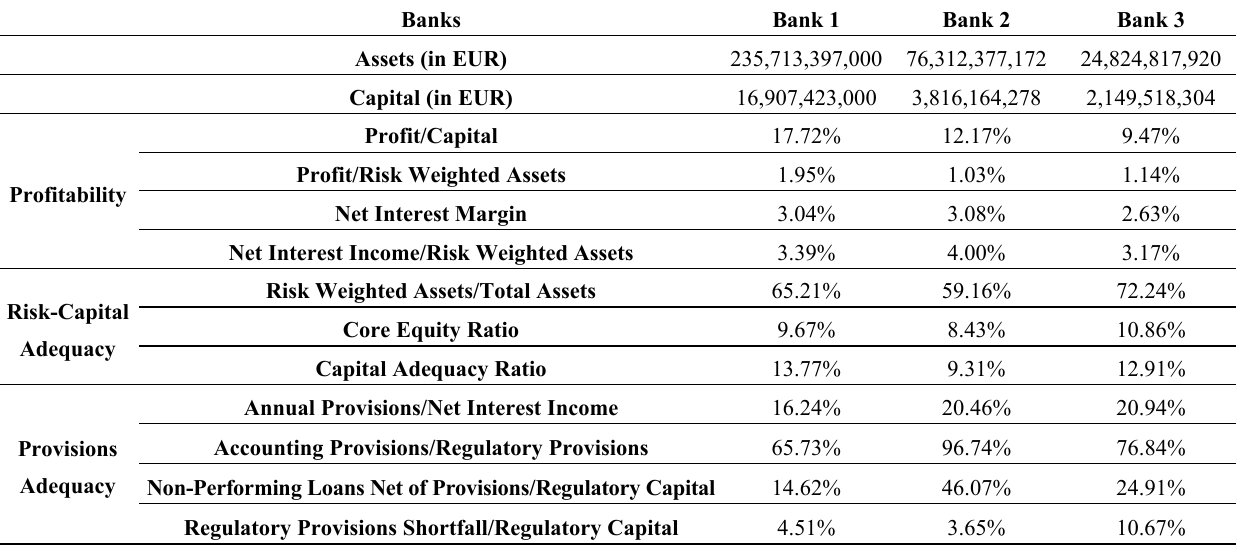
Table 1. Basic Indicators Analysis by